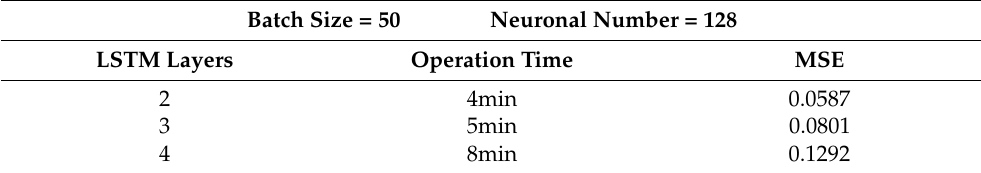
Figure 7. Comparison of LSTM layer number fitting effects. Table 3. LSTM layer prediction